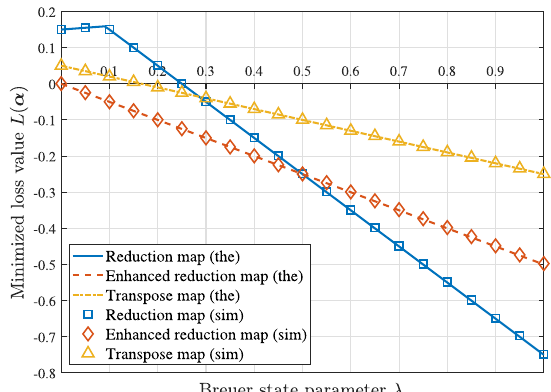
Fig. 7 Numerical results on the four-qubit Breuer states de fi ned in Eq. (44). Each line depicts the smallest eigenvalue of every Breuer state with parameter p ∈ [0, 1] under the corresponding map. This line of the smallest eigenvalues is a lower bound of the loss function L ( α ). Each marker depicts the minimized loss value obtained by simulations (sim) of Algorithm 1 on a chosen Breuer state, aligning with the theoretical (the) line.